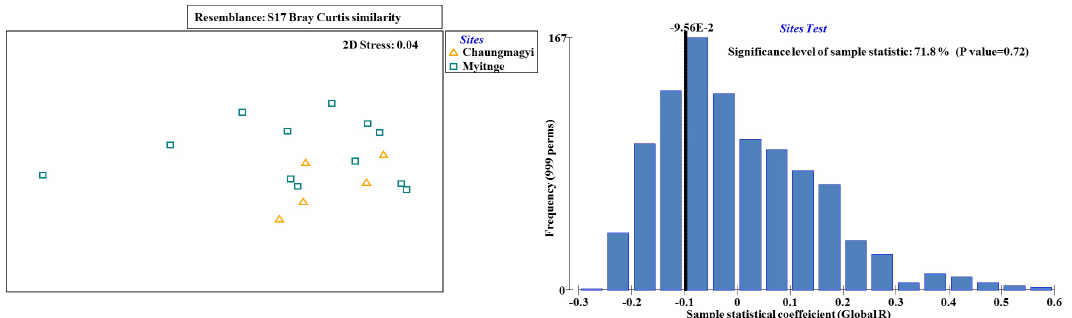
Figure 3. Matching of indices by three methods between two study rivers by non-metric multidimensional scaling (MDS) plot ( Left ); and matching of indices by three methods among all sampling sites by Global R statistic test by one way analysis ANOSIM ( Right ).